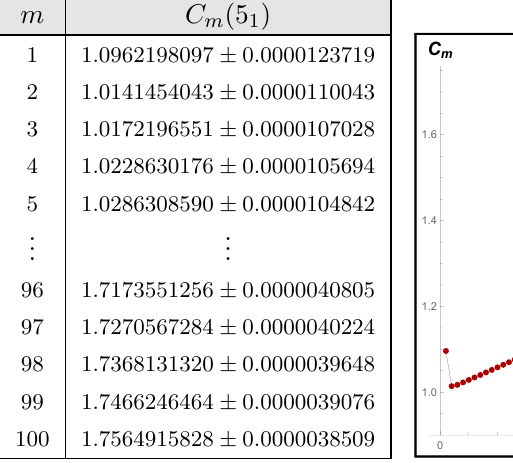
Table 4. Values of C m (5 1 ) . Figure 7. Variation of C m (5 1 ) with m